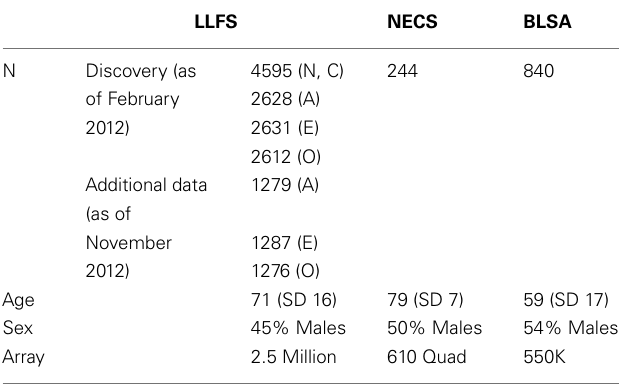
Table 1 | Characteristics of